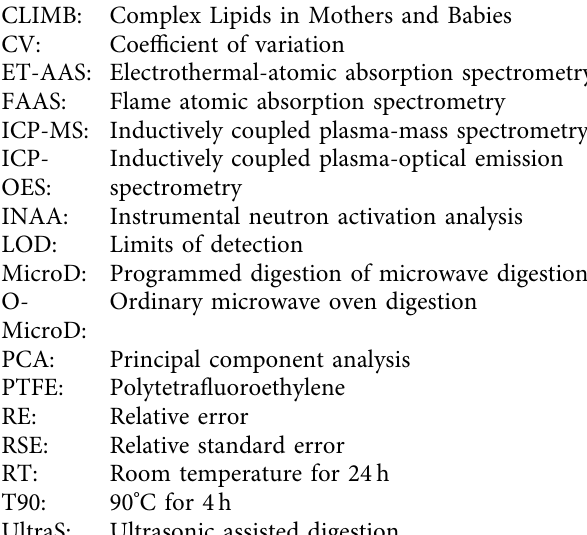
Figure S1: the extraction efciency of internal standard el- ements (Bi, In, and Rh) in fve diferent digestion methods for human hair. Figure S2: the bar graphs show the coef- fcient of variation (%) of each metal across fve diferent digestion methods for human hair. Table S1: microwave digestion procedure parameters. Table S2: linear relationship and detection limit of each element in the standard solution. Table S3: number of identifed elements, concentrations ( μ g/ L), and CVs (%) of each element classes in human hair, compared across fve diferent digestion methods. Table S4: the quantitative concentrations ( μ g/L) of identifed metals in human hairs across the fve diferent digestion